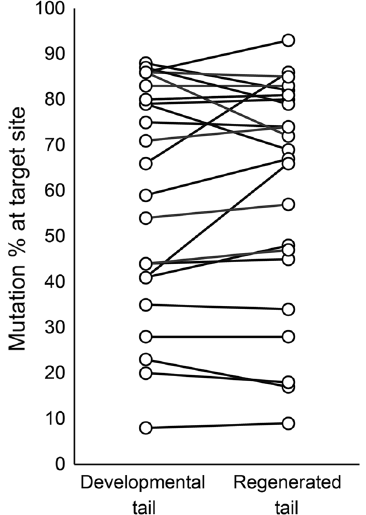
Figure 4. il11ra.L KO cells can contribute to form the regenerated tail. Estimated mutation ratio at the guide RNA #1 target site of the developmental and regenerated tail of each individual is shown. Linked points represent the same individual. n = 24. P = 0.44, paired t -test. Representative result of 2 experiments is shown. The result of the second experiment is shown in Fig.